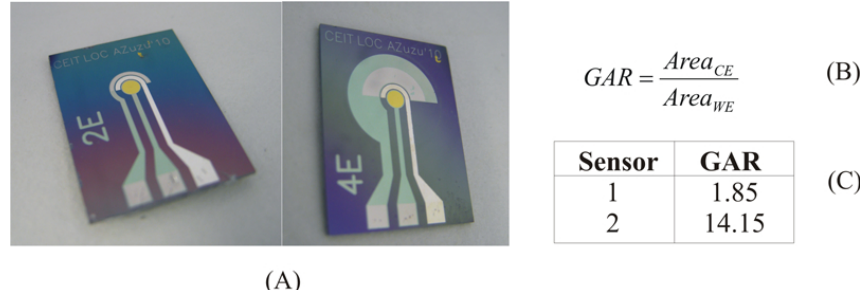
Figure 1. (A) Fabricated chips: sensor 1 and sensor 2, (B) geometry area ratio, (C) GAR values.